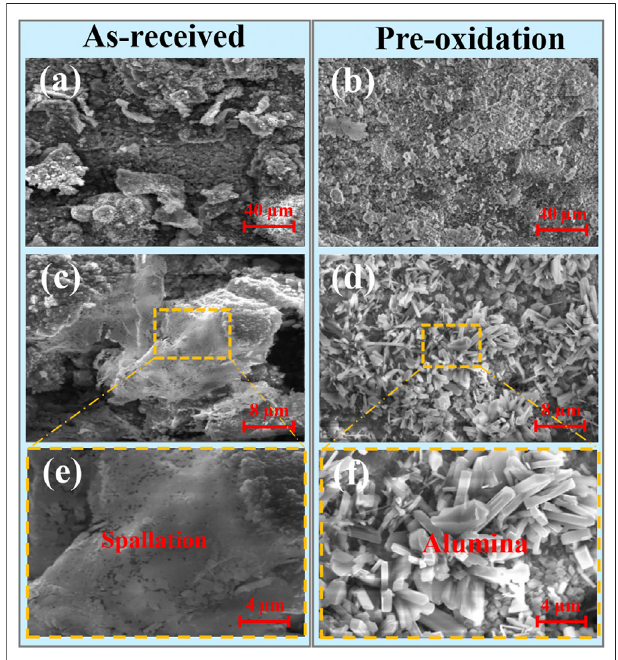
FIGURE 3 | Surface morphologies of the aluminide coating after hot corrosion for 120 h in Na 2 SO 4 salt at 1050 ° C for (A,C,E) as-received and (B,D,F)